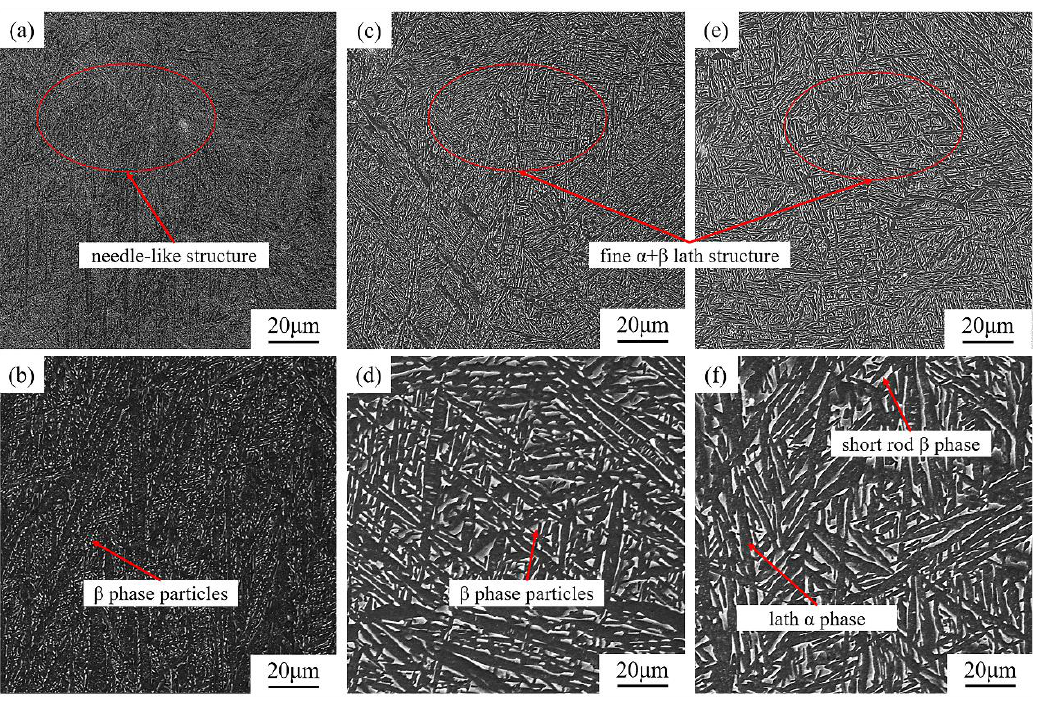
Figure 4. SEM micrographs of heat-treated as-built TA15; ( a ) 630 °C , ( c ) 750 °C and ( e ) 800 °C for 2 h; ( b , d , f ) show higher magnification of the micrographs.